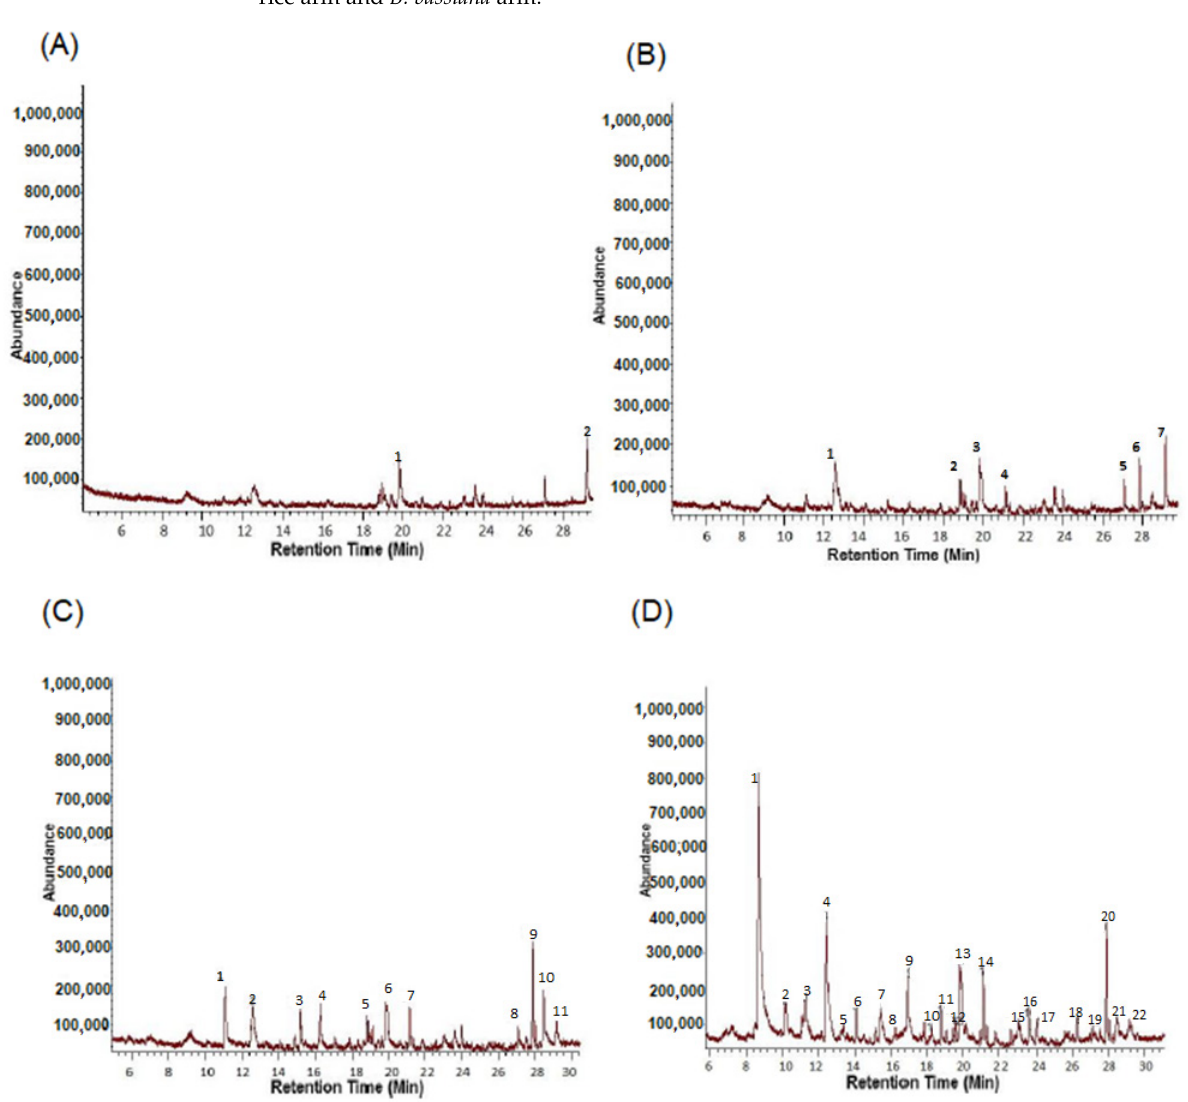
Figure 3. ( A ) GCMS analysis for Tenax (Control). ( B ) GCMS analysis from Rice ( Oryza sativa ) sam- ple. ( C ) GCMS analysis from samples of 10 g of B. bassiana. ( D ) GCMS analysis from samples of 20 g of B.